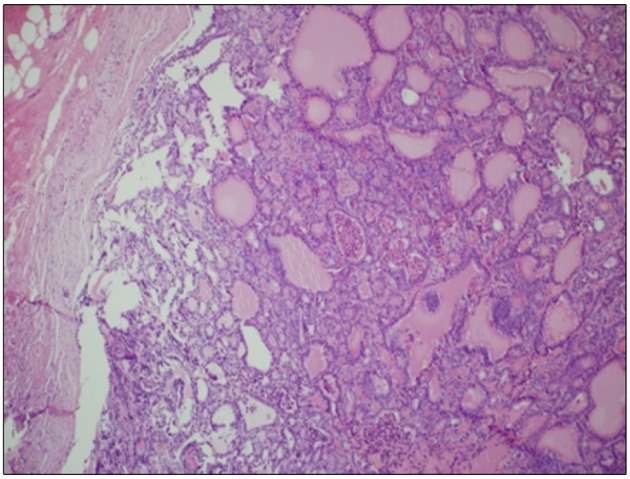
Thyroid tissue. Hematoxylin Eosin staining of histological slides, magnification 10 × 1.